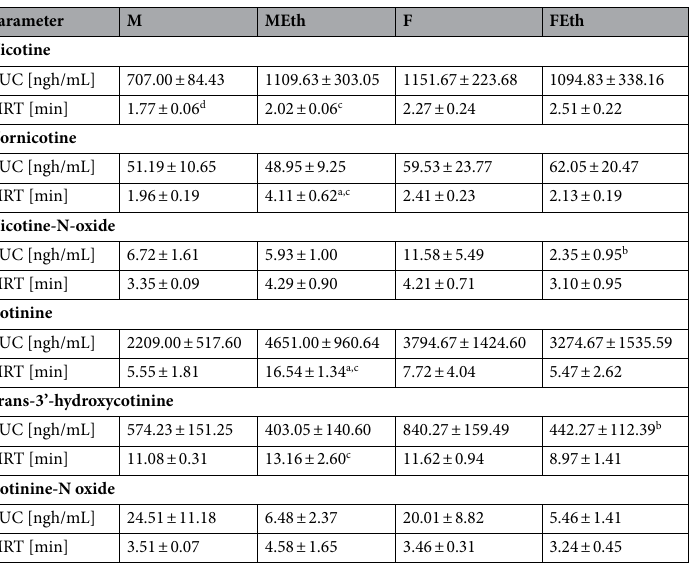
Table 3. Pharmacokinetic parameters of plasma nicotine and metabolites in alcohol preferring and non- preferring rats. Data represent mean ± SD , n = 18 in each group. AUC total area under plasma concentration– time curve for the dosing interval, MRT mean residence time. a Statistically significant differences between male rats preferring ethanol versus non-preferring ethanol. b Statistically significant differences between female rats preferring ethanol versus non-preferring ethanol. c Statistically significant differences between male rats preferring ethanol versus female rats preferring alcohol. d Statistically significant differences between male rats non-preferring ethanol versus female rats non-preferring